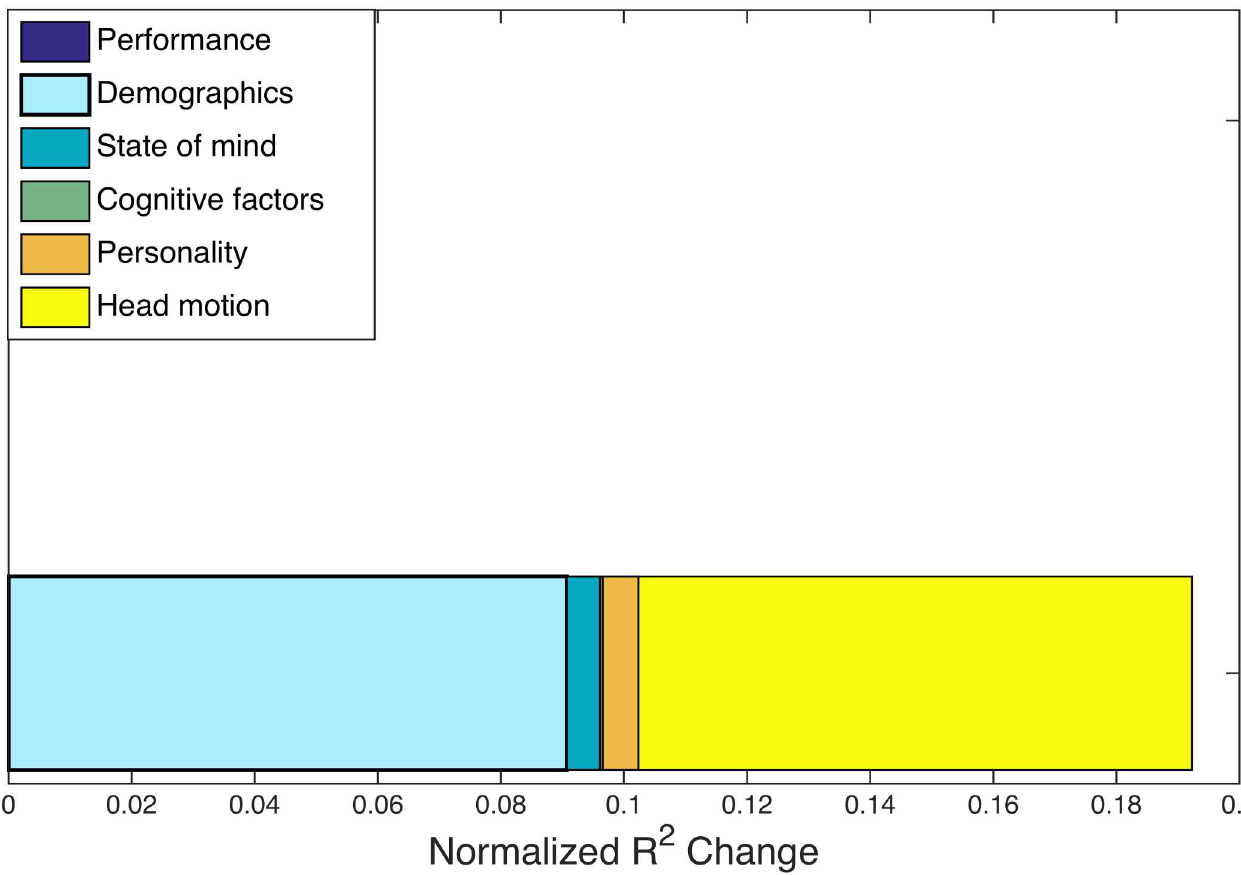
Fig 9. Age-memory R 2 changes. Normalized R 2 changes with respect to hypergraph cardinalityacross individualsin the age-memory study. The largest normalized R 2 changes are from the demographics factor and head motion measure, but the demographics factor is the only significant predictor of hypergraph cardinality. In this figure, predictionsignificanceis denotedwith a bold outline. The compositionof R 2 changes for the age- memory task is consistent with that seen for the multi-task data in Fig 6, in that the normalized R 2 change is largely due to the demographics